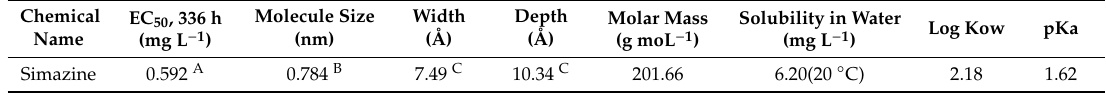
Table 1. Physico-chemical characteristics of